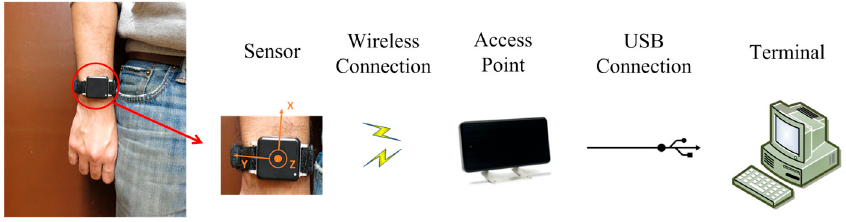
Figure 4. Illustration of sensor placement and the hardware platform.